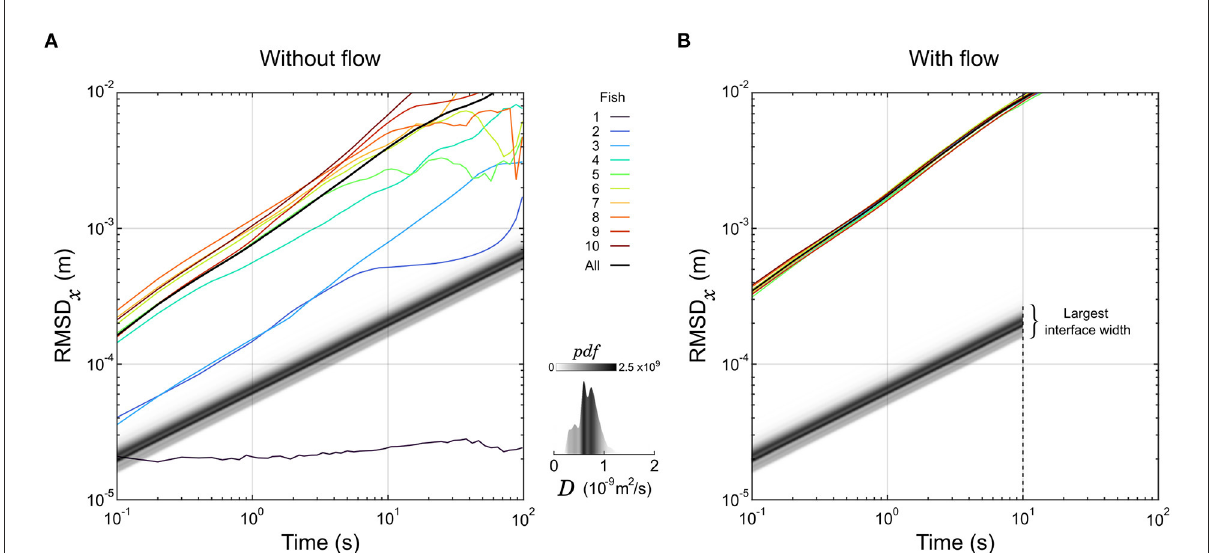
FIGURE2 Dynamics of larval zebrafish and diffusion of organic compounds. (A,B) The root mean square displacement along the x -axis (RMSD x ) of 10 individual larvae are displayed as a function of the sampling duration in the absence (A) or presence (B) of a flow. The RMSD computed over all larvae are displayed in black curves as well. For comparison, the displacement of the front of an interface at a given normalized concentration α is a straight line with slope 1/2. These lines are represented for α 1 % in shades of gray corresponding to the distribution of the diffusion = coefficient D of 5000 organic compounds. The latter distribution is also represented separately in the insert. Under flow (B) , the largest interface width sits at the end of the test chamber, corresponding to the spreading of a front in 10 m 2 .